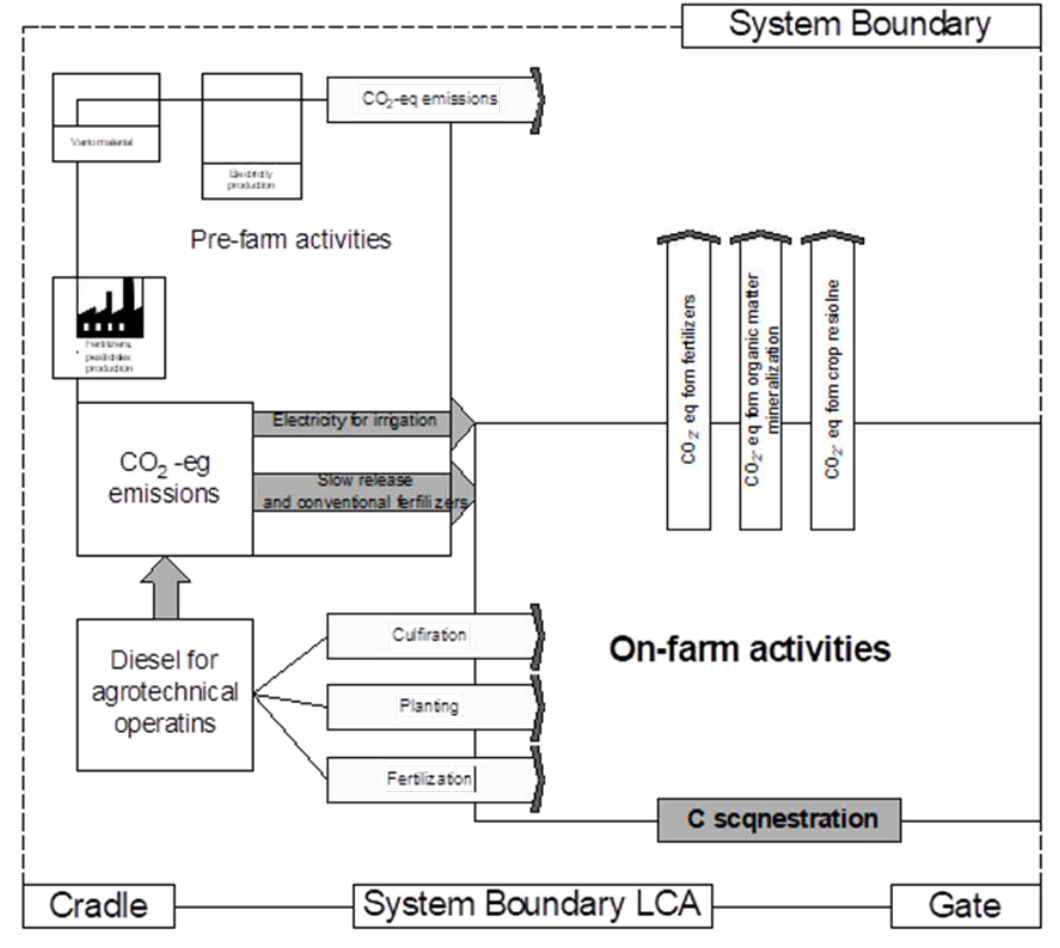
Figure 2. System boundaries of the experiment.